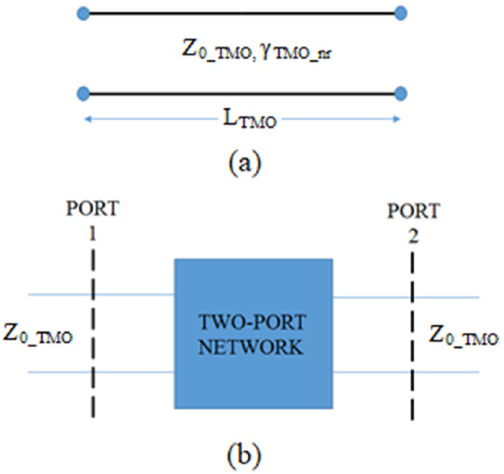
Figure 10. Standard transmission line; ( a ) Transmission line of length L TMO and ( b ) a two-port network terminated in Z 0_TMO .